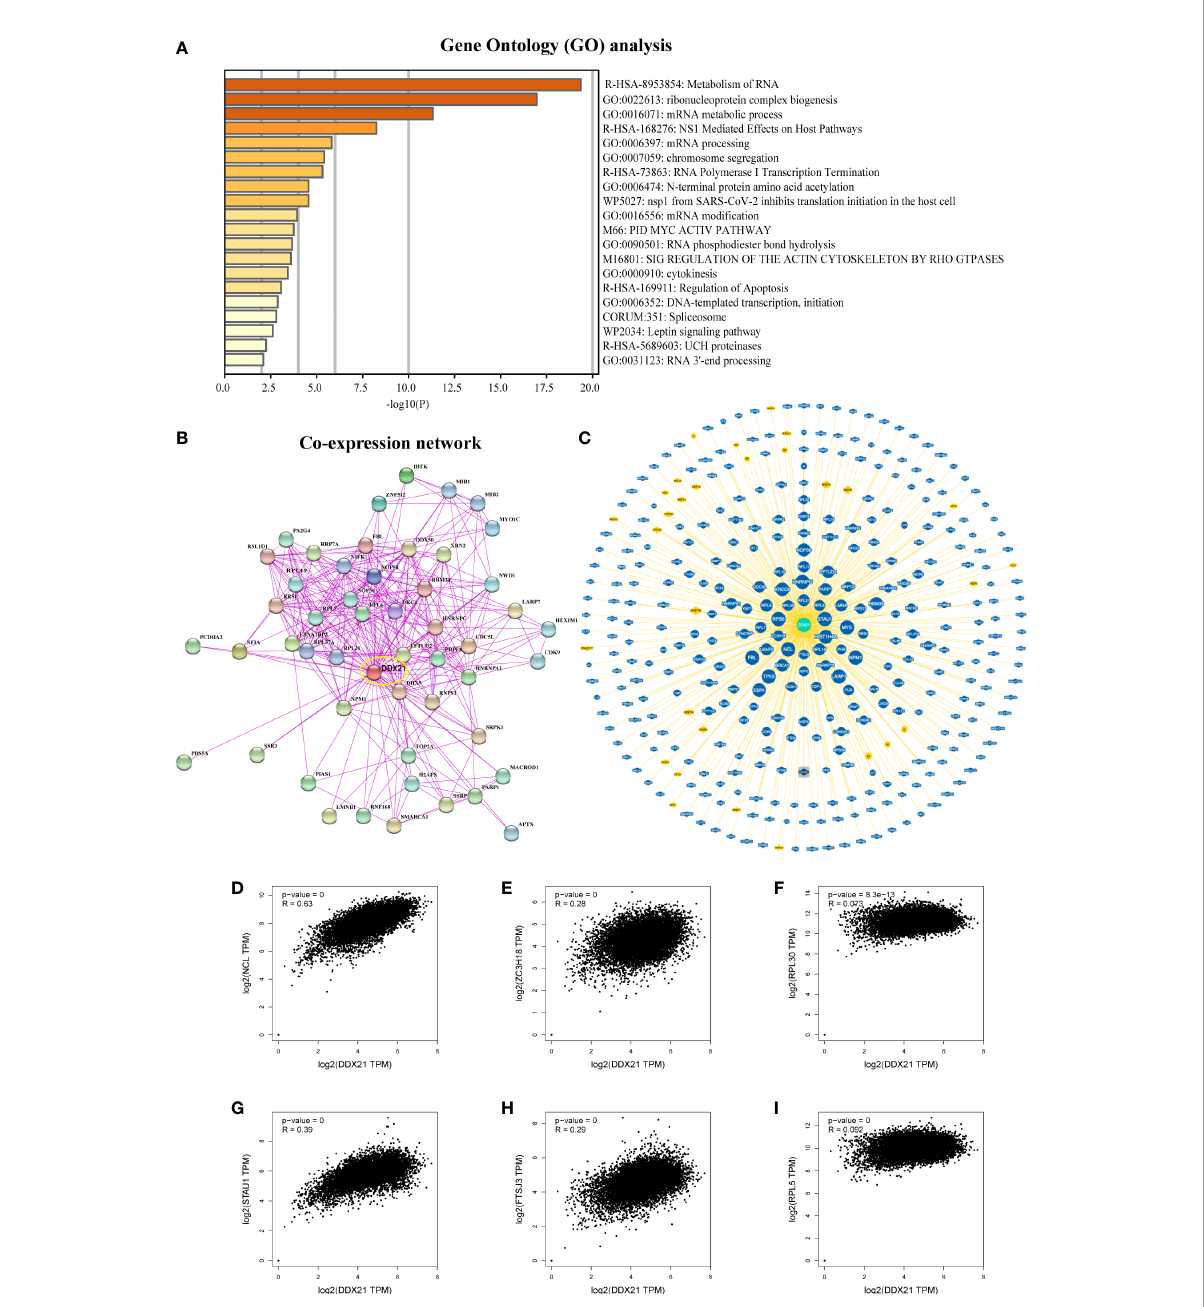
FIGURE 8 DDX21-related gene enrichment analysis. (A) Gene Ontology (GO) analysis of the top 100 genes co-expressed with DDX21 obtained by GEPIA2. (B) Co-expression network of 50 genes co-expressed with DDX21 obtained by the STRING tool. (C) DDX21 – protein interactions obtained by BioGRID. (D − I) Correlation analysis between DDX21 and RPL5, RPL30, ZC3H18, NCL, FTSJ3, and STAU1 conducted by GEPIA2 across all tumor samples in